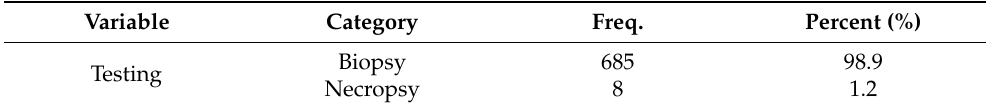
Table 2. VetCompass Australia database overall histopathology diagnosis in splenectomized dogs from primary-care veterinary